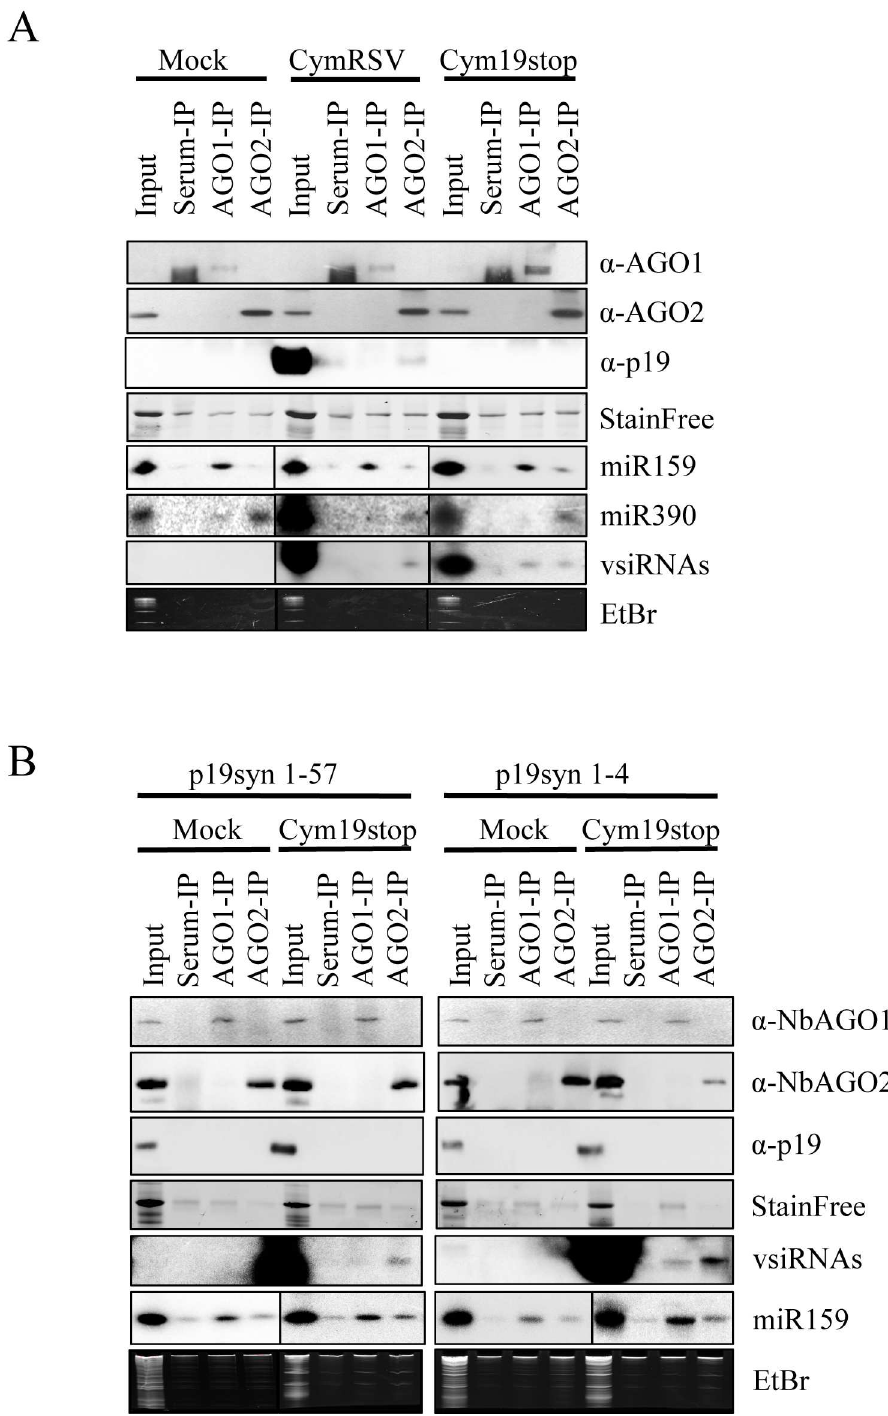
Fig 5. Northern blot analysis of NbAGO1- and NbAGO2-bound vsiRNAs and miRNAs. ( A ) Serum- NbAGO1- and NbAGO2-immunoprecipitations from mock-, CymRSV- or Cym19stop-infected wt N . benthamiana plants as shown: upper panels, Western blots for AGO1, AGO2 and p19 are shown (StainFree gel picture shown as loadingcontrol); lower panels, Northern blots of AGO1-specific miR159, AGO2-specific miR390 and vsiRNAs (ethidium-bromide stain shown as loadingcontrol). (B) Serum- NbAGO1- and NbAGO2-immunoprecipitations from mock- or Cym19stop-infected transgenic p19syn lines as shown: